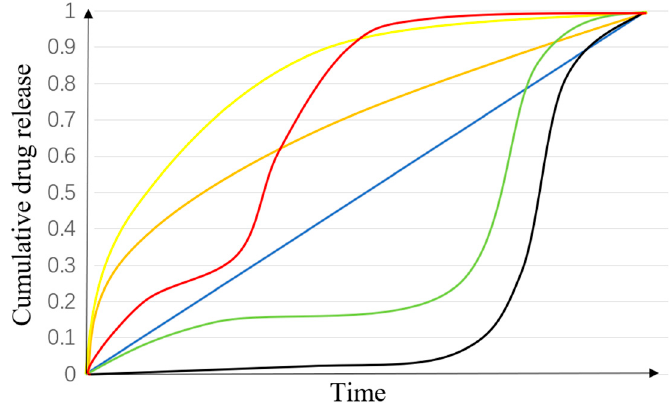
Figure 12. Different drug release profiles. Red: tri-phasic release with a short phase II; yellow: burst release and a quick phase II; blue: a zero-order release; orange: burst release with a zero-order release; green: a classical tri-phasic release; black: a classical bi-phasic, which is similar to a tri-phase without the burst release.